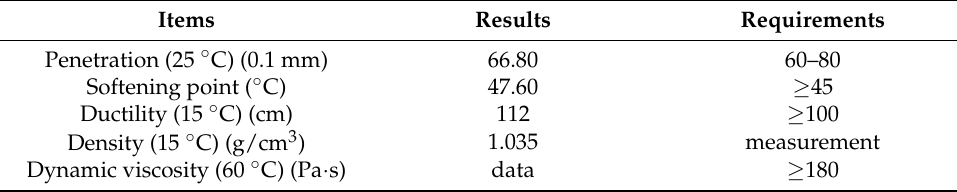
Table 1. The physical properties of base asphalt.